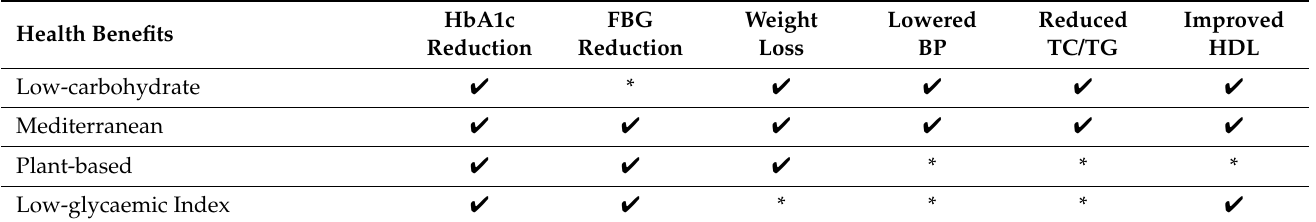
Table 6. The health benefits of dietary patterns for adults with type 2 diabetes based on this um- brella review.